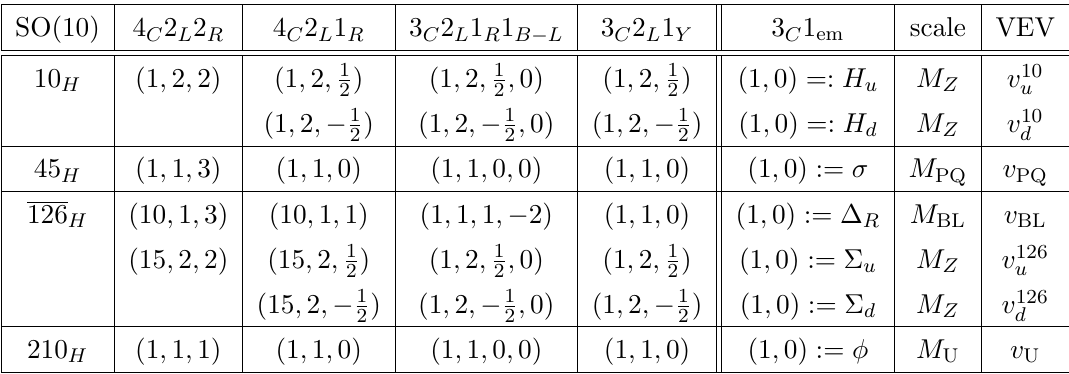
Table 3 . Decomposition of the scalar multiplets according to the various subgroups in our breaking chains. We only display the multiplets which get nonzero vacuum expectation values (VEVs) in the di(cid:11)erent models considered in the paper. \Scale" refers to the contribution to gauge boson masses induced by the VEV of a multiplet, rather than to the mass of the multiplet itself. According to the extended survival hypothesis, we only keep the multiplets which acquire a VEV at lower scales, (with the exception of (cid:6) u ; (cid:6) d , which decouple at M BL in order to give rise to a low-energy 2HDM limit). All submultiplets not in the list are assumed to be at the uni(cid:12)cation scale M U . In all cases, we have M Z < f M BL ; M PQ g < M U . The di(cid:11)erent relations between M BL and M PQ are